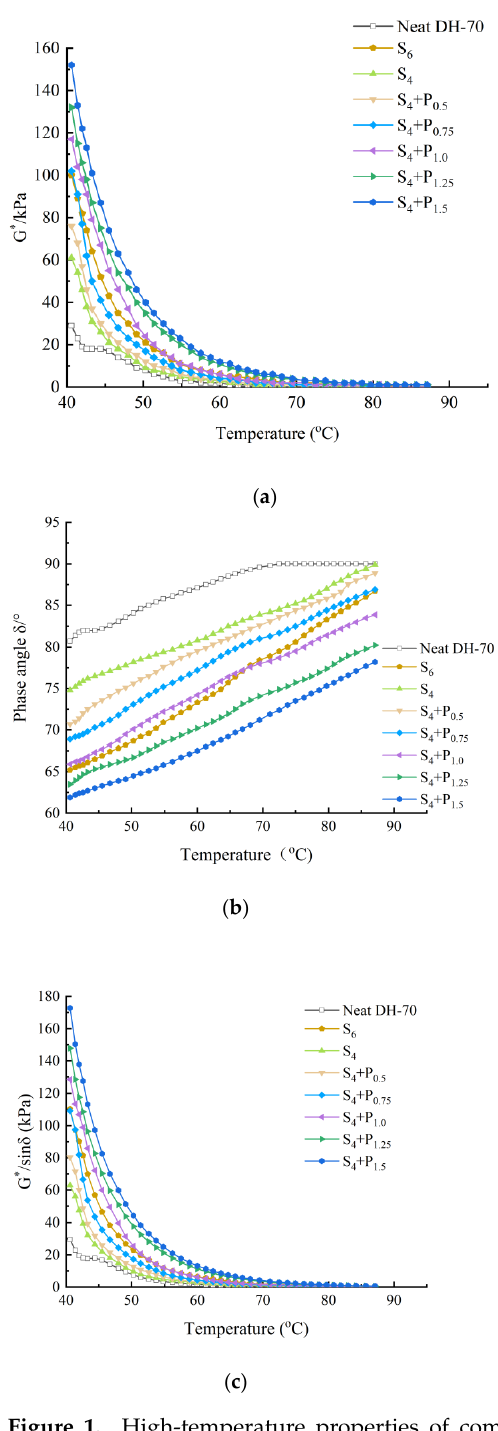
Figure 1. High-temperature properties of compound ratio of PPA – SBS and DH – 70# neat asphalt: ( a ) Complex modulus-temperature results; ( b ) Phase angle-temperature results; ( c ) G*/sinδ -tenperature results.